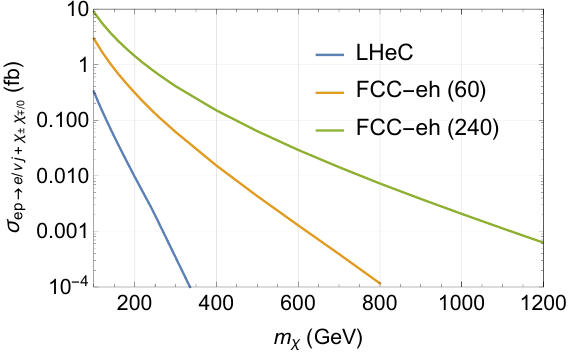
Figure 5 . Production rate of Higgsinos at e Higgsino LLPs is 40 (cid:24) (cid:0)